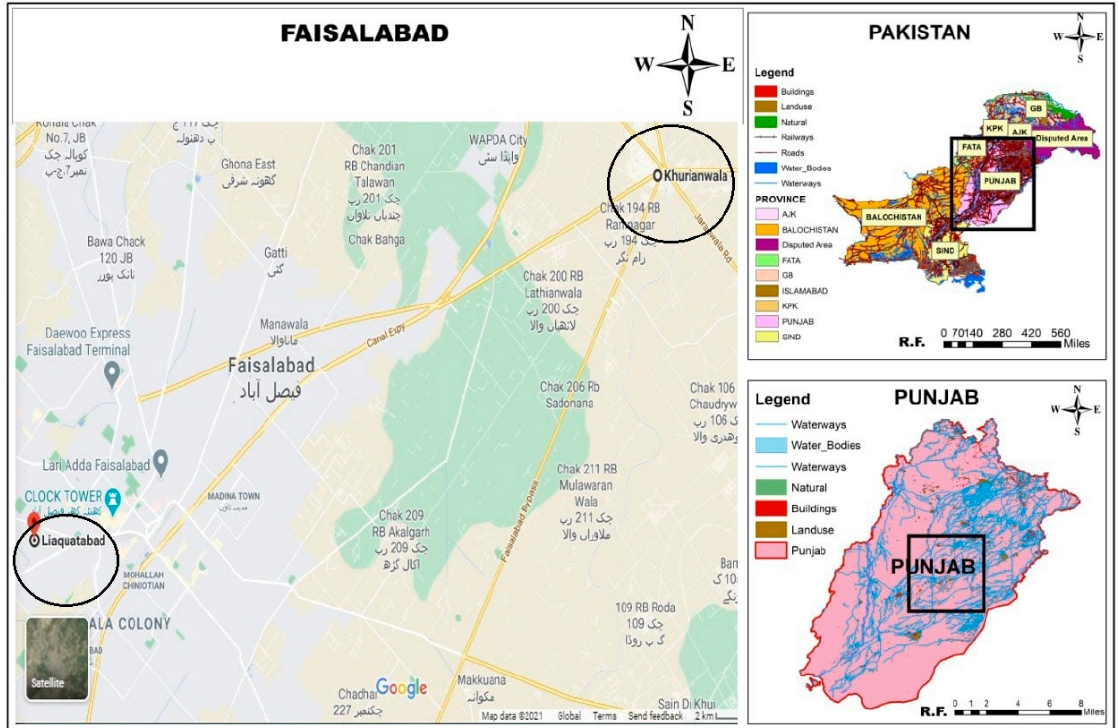
Figure 1. The map showing the selected sites of study area in Faisalabad.